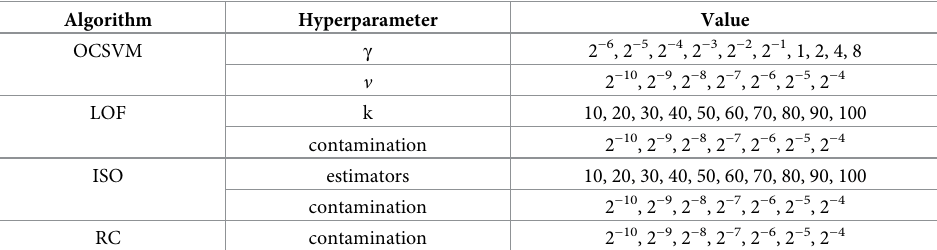
Table 1. Hyperparameters evaluated to find the best F-measure.